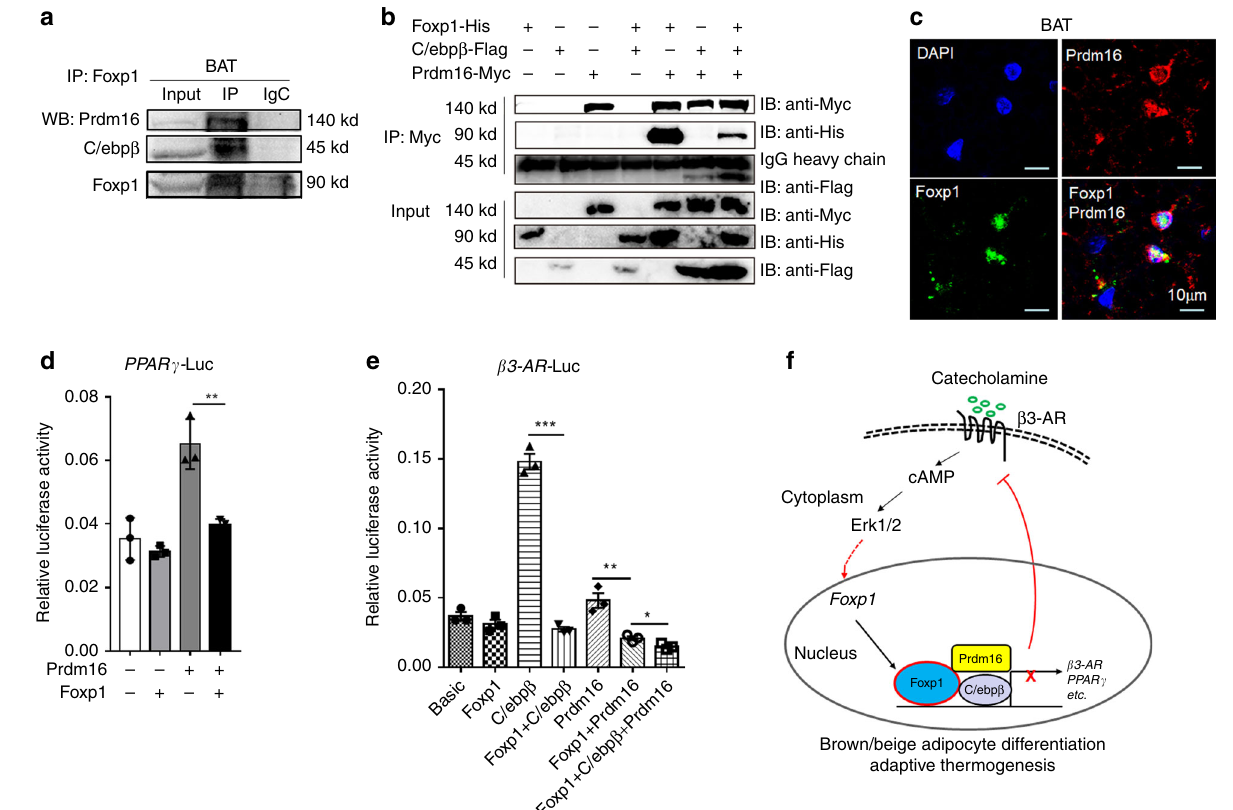
Fig. 6 Foxp1 physically interacts with Prdm16-C/ebp β complex in brown adipocytes. a , b Co-immunoprecipitation validated the physical interaction between Foxp1, C/ebp β and Prdm16 proteins in cell lysates from 293T cell lines transfected with indicated plasmids ( a ), or brown adipocytes induced from stromal vascular fractions ( b ). c Immuno fl uorescence analysis showed the co-localization of Foxp1 and Prdm16 in the nucleus of BAT from wild type mice at age of 1 month old. Bar, 10 μ m. d Luciferase reporter assay showed the transactivation of PPAR γ -Luc by Foxp1 and Prdm16 protein in 3T3-L1 cell lines. n = 3 biologically independent samples/each group. e Luciferase reporter assay showed the transactivation of β 3-AR -Luc by Foxp1, C/ebp β and Prdm16 protein in 293T cell lines. n = 3 biologically independent experiments; * P < 0.05, ** P < 0.01, *** P < 0.001; error bar, mean ± SEM. f Diagram depicting the mechanisms that Foxp1 represses brown/beige adipocyte differentiation and adaptive thermogenesis. Expression of Foxp1 is induced by β 3-AR/cAMP/ Erk1/2 cascades. Conversely, Foxp1 suppresses β 3-AR transcription by counteracting the activity of Prdm16-C/ebp β